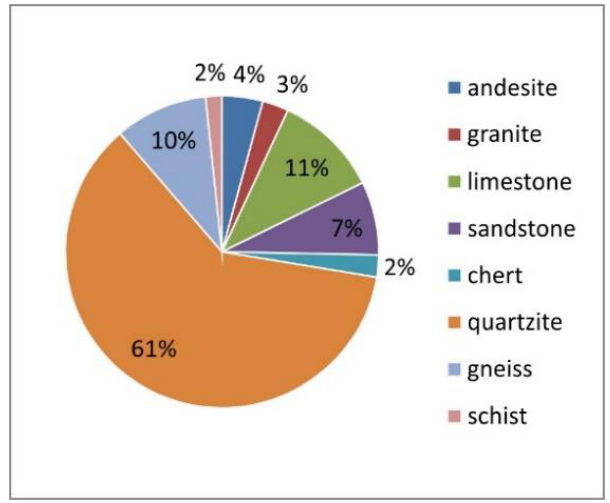
Figure 4. Petrographic composition of gravel from RCA.